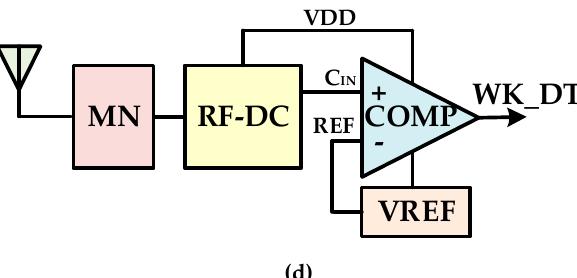
Figure 4. The previous wake-up receiver architecture: ( a ) RF envelope detector (RFED) based with analog to digital converter (ADC); ( b ) RFED based with band pass filter (BPF); ( c ) frequency conversion with LO; ( d ) passive circuit with RF-DC.